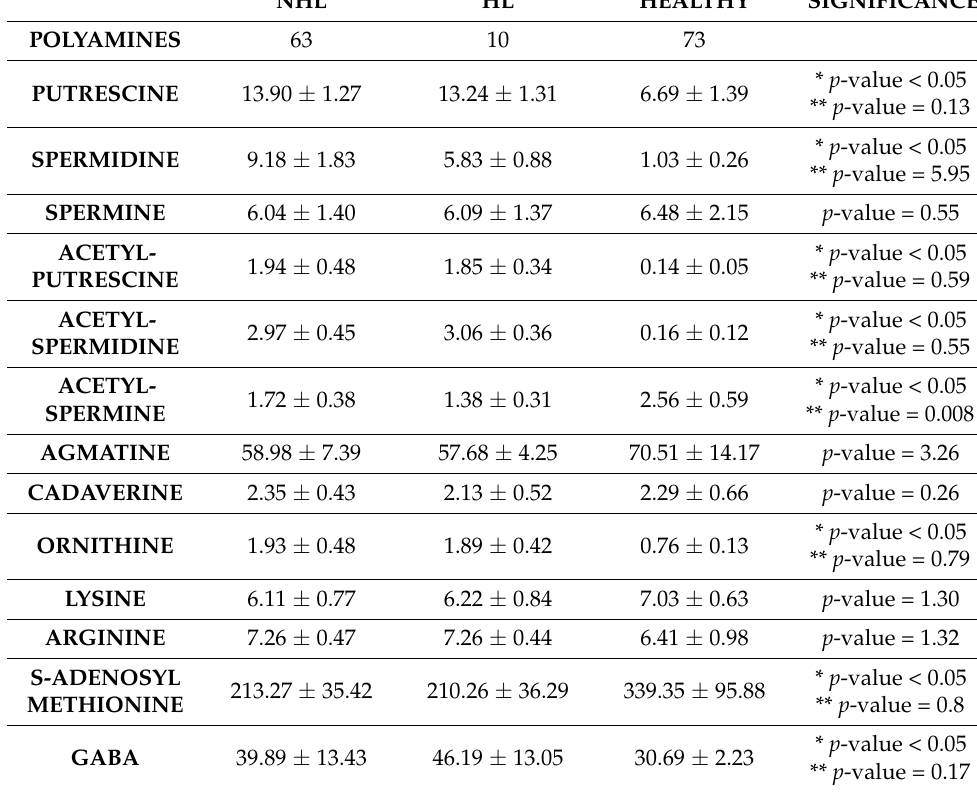
Table 3. Analysis of polyamine levels in the three groups (LNH, LH and HEALTHY). Kruskal–Wallis test significant for p < 0.05 indicated with *. ** indicates the p -value obtained with Student’s t -test unpaired between LNH vs. LH, p < 0.05 statistically